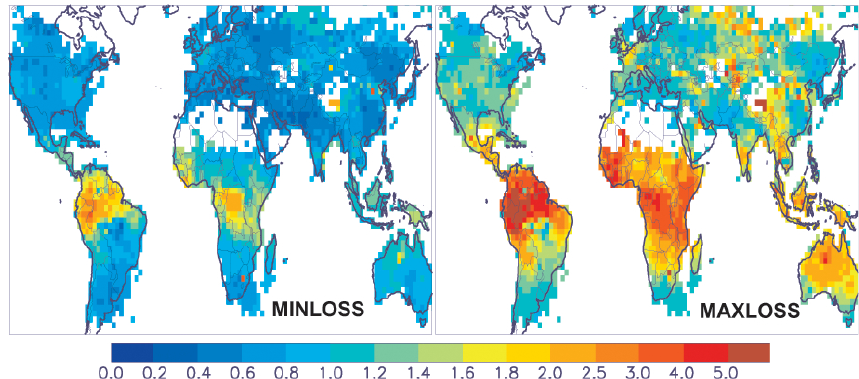
Fig. 6. Annual total NO x emission update (optimized/a priori) inferred from inversion MINLOSS (left) and MAXLOSS (right).